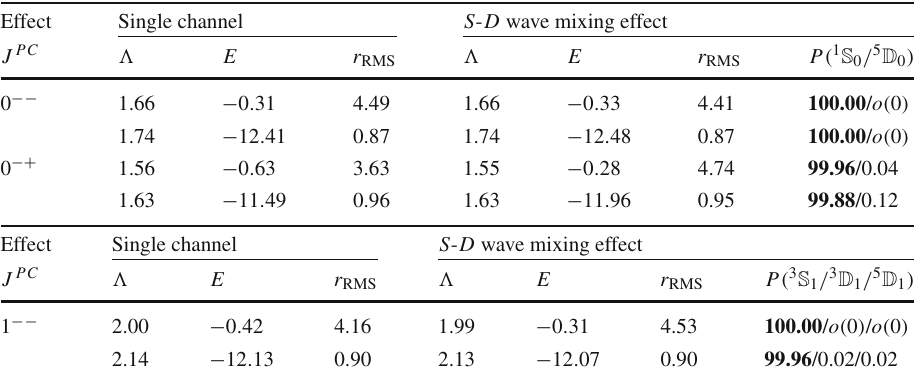
Table 2 Bound state solutions for the S -wave D ∗ s ¯ D s 1